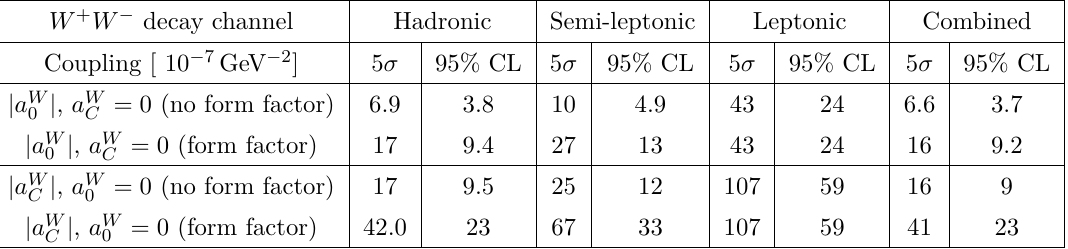
Table 6 . Sensitivities to the anomalous couplings a W and a W assuming an integrated luminosity 0 C √ of 300 fb − 1 and a center of mass energy of s = 14 TeV. The sensitivities for each decay channel of the W + W − is displayed in the columns. The combined sensitivities are presented in the last column. Sensitivities assuming no form factor and a form factor with cutoff scale Λ cutoff = 2 TeV are displayed in the rows. These sensitivities establish the coupling values probed at 5 σ or those which could be excluded at 95%